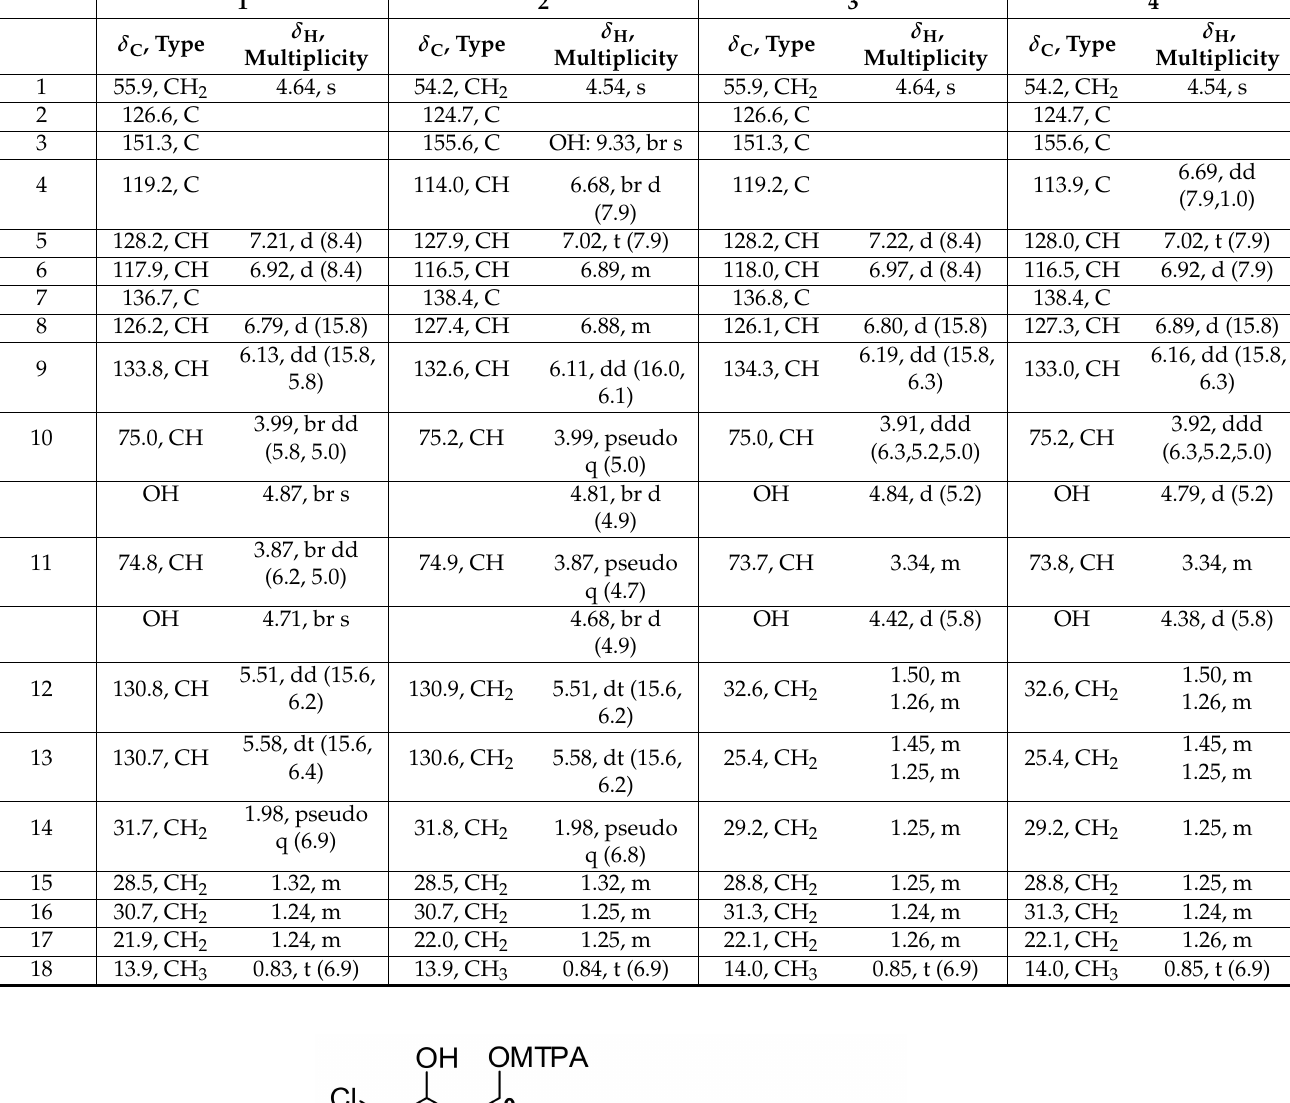
Table 2. NMR data of metabolites 1 – 4 in DMSO- d 6 ( 1 H 500 MHz, 13 C 125 MHz).